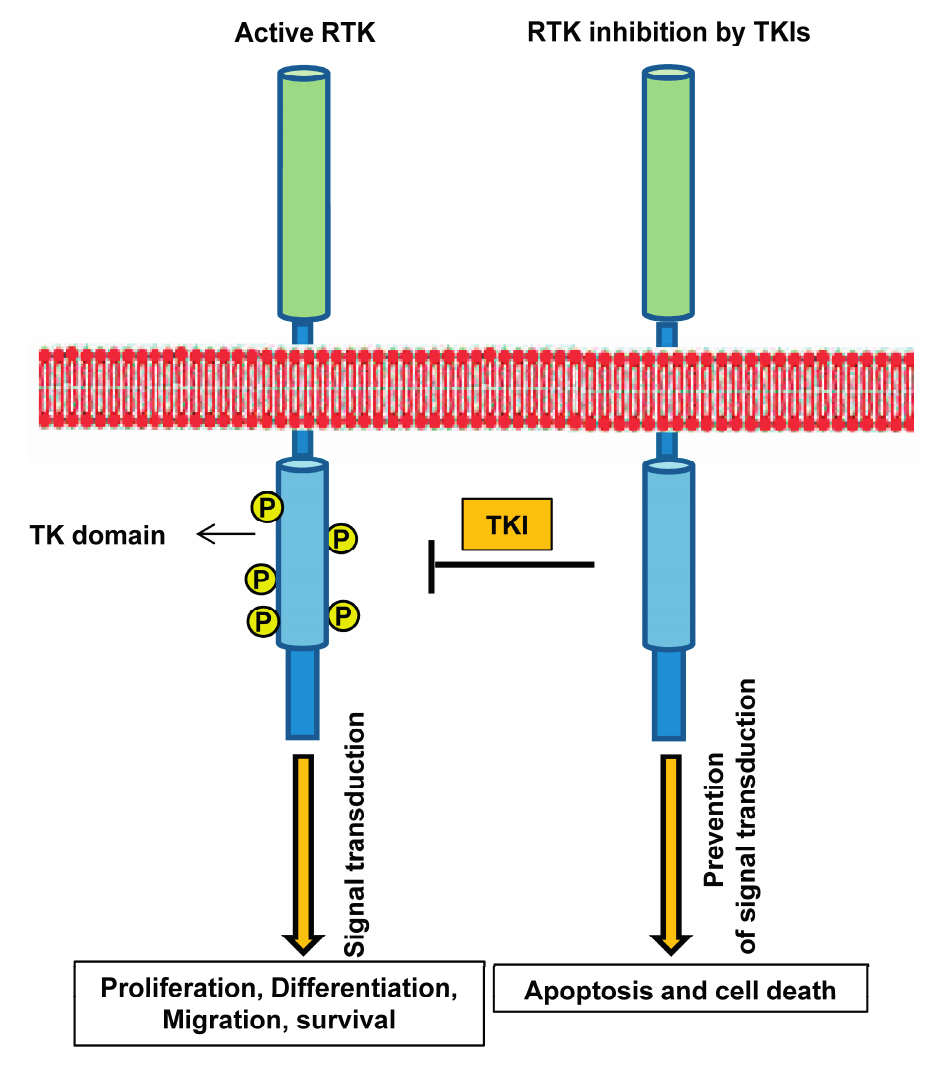
Figure 1. Targeting receptor tyrosine kinases by tyrosine kinase inhibitors (TKIs). Blocking small molecule inhibitors of kinase domain (TKIs) prevents the phosphorylation of the receptor at TK domain and interferes with cell proliferation, differentiation, migration, and survival and induces cell apoptosis. Phosphate groups are denoted as yellow